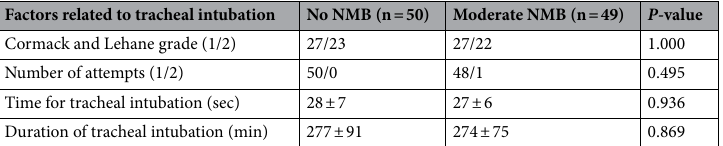
Factors related to tracheal intubation